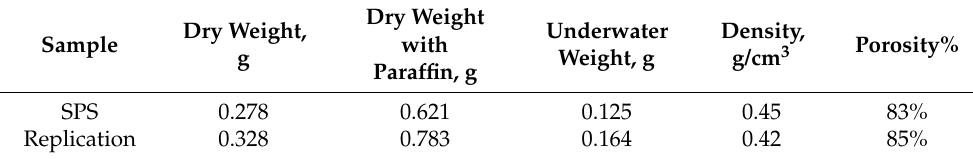
Table 4. The measurements of density and porosity of aluminum